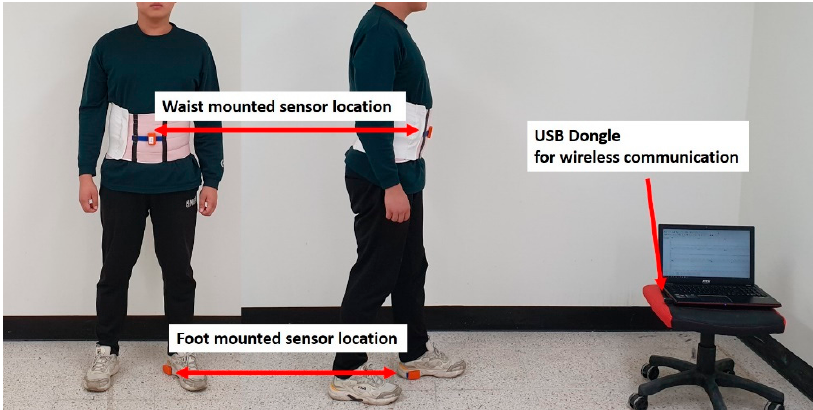
Figure 8. Mounted-sensors’ locations and configuration of the experiment.